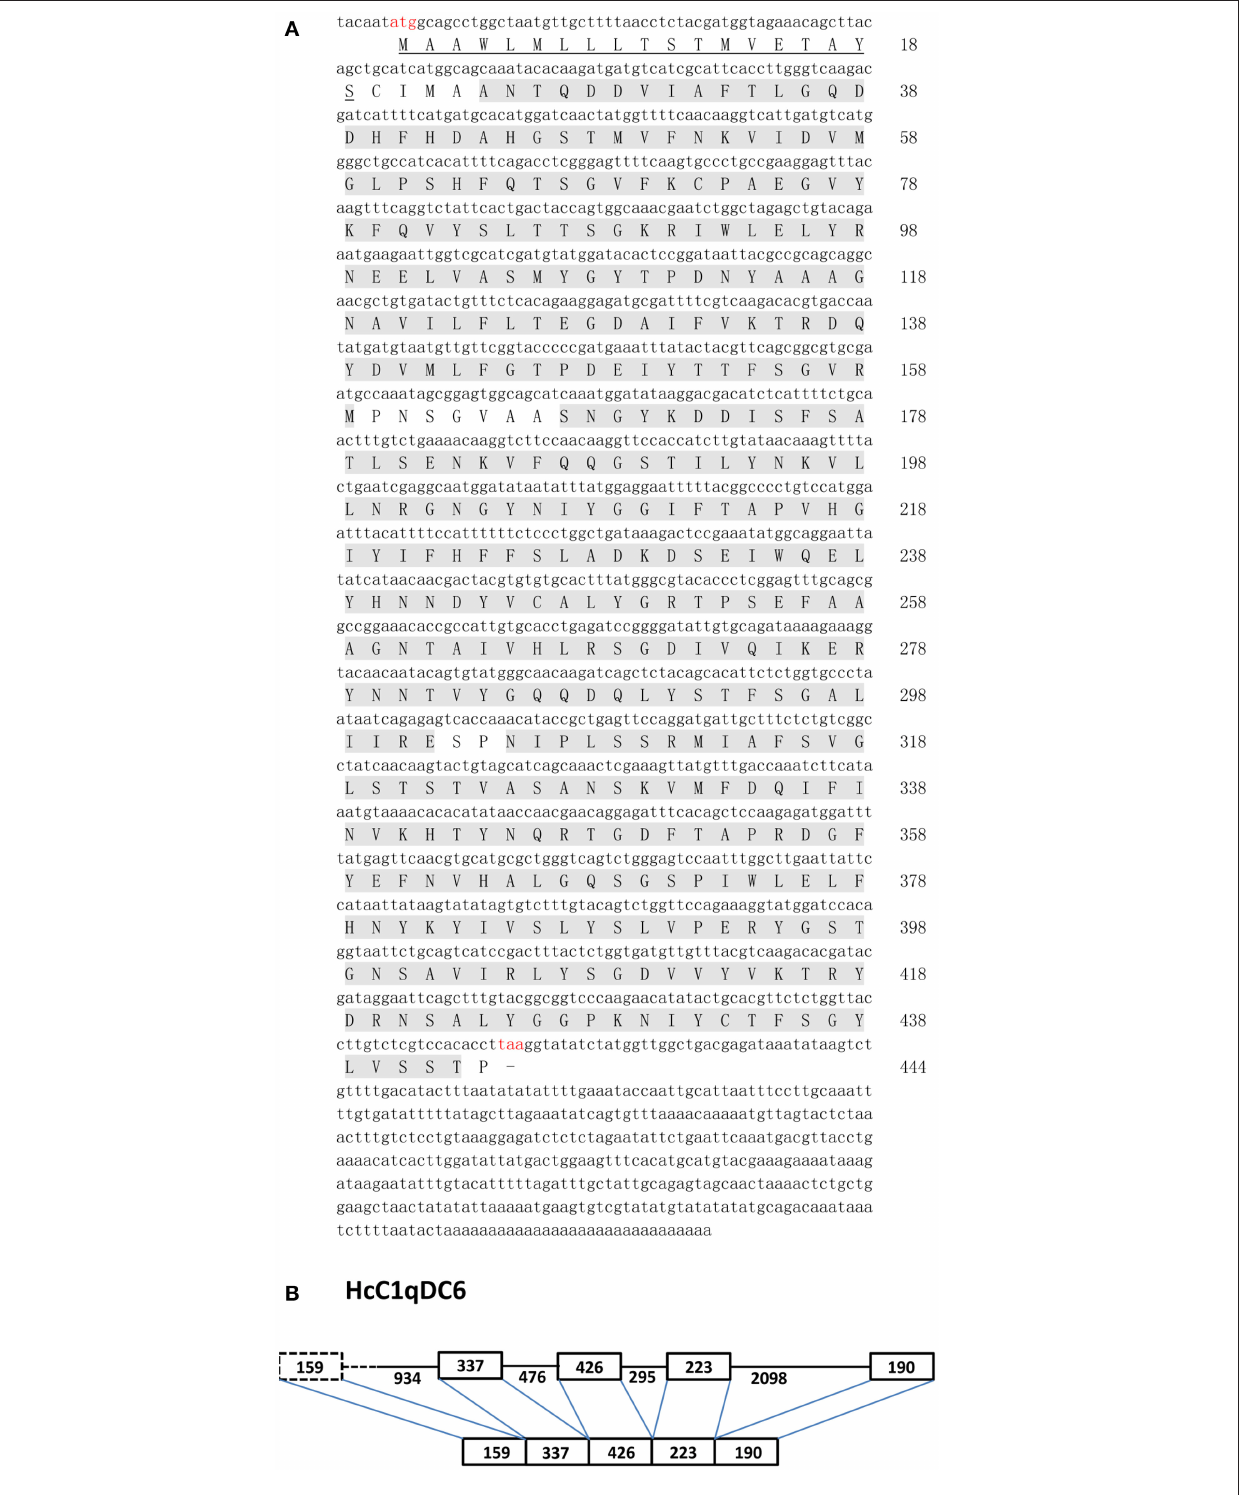
Frontiers in Physiology |